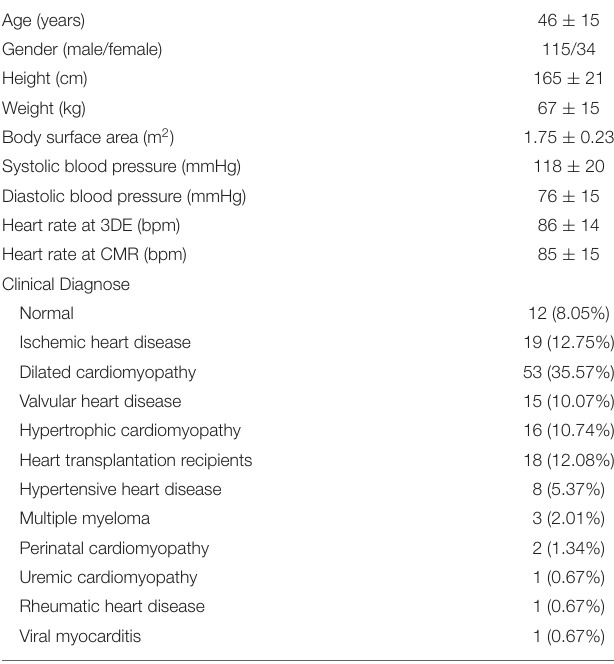
TABLE 1 | Clinical characteristics of study population ( n =